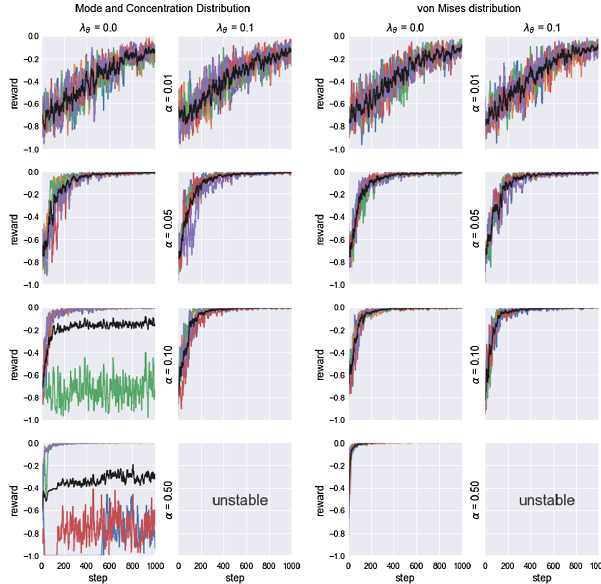
4. Plot of the reward received by the agent versus step number. For this task the agent must guess the number − 0.5. The standard deviation of the reward is 1.0. The agent begins the task with mode − 2.5 and standard deviation 1.0. For each of the three agent types, we varied the eligibility trace memory parameter, λ θ , and the learning rate, α , as shown in the figure. For each setting 5 trials (represented by the colored lines) were performed and the task was ended after 1000 steps. A 10-step rolling average was performed to smooth the plots for ease of comparison. The black line is the average of all 5 trials in each plot.